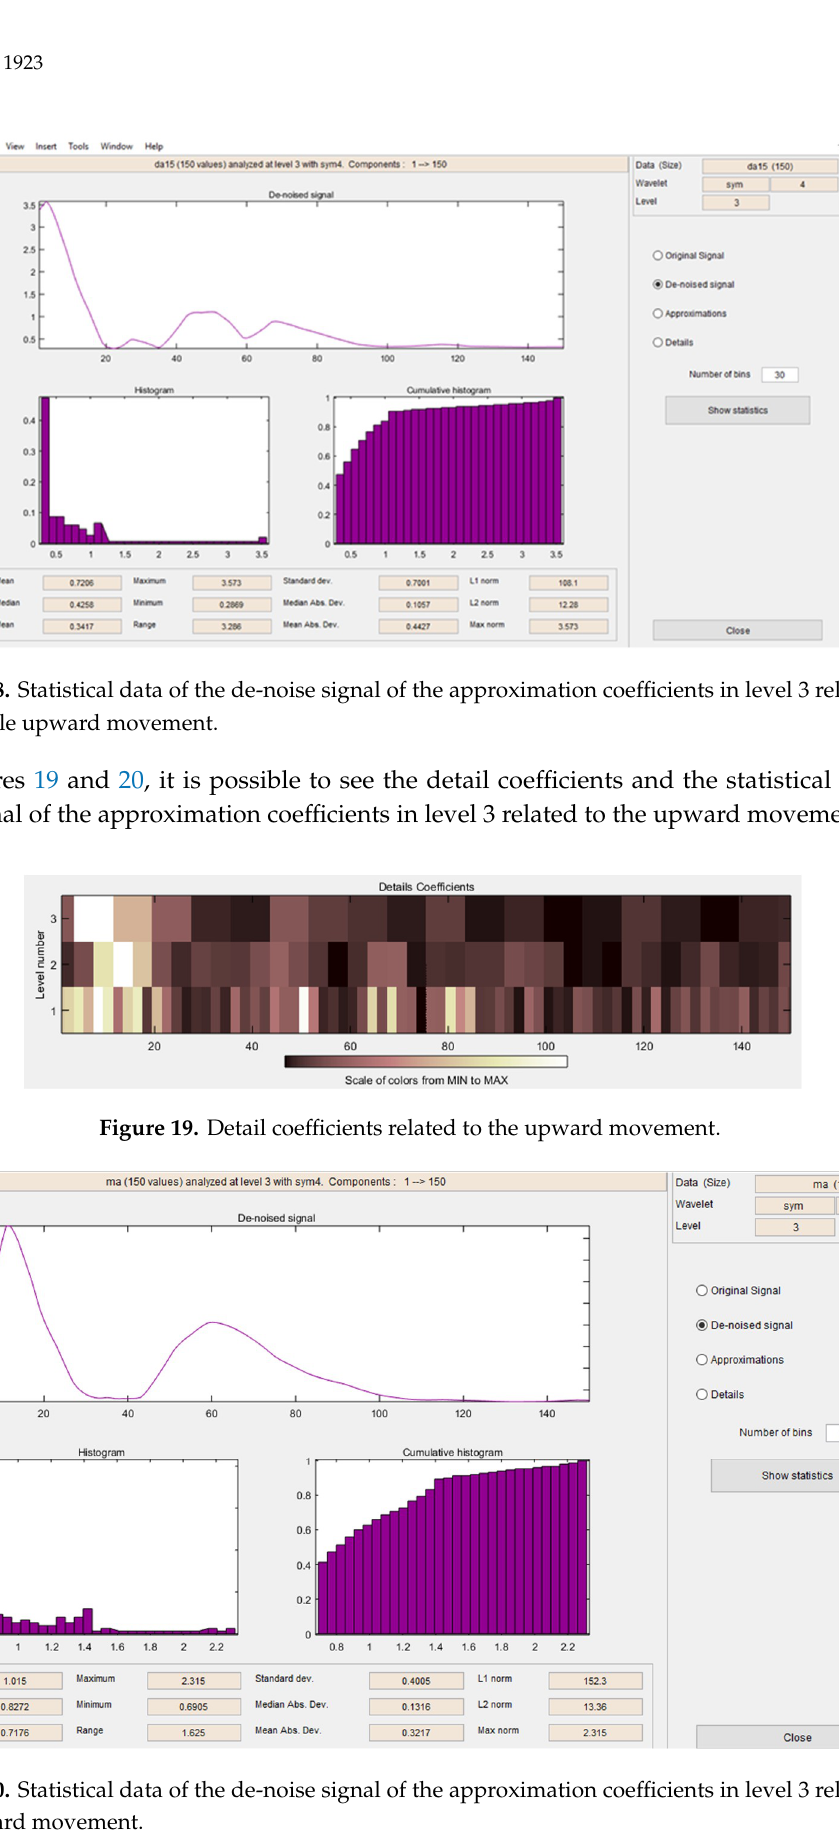
Figure 21. Detail coefficients related to the upward-downward movement. Figure 22. Statistical data of the de-noise signal of the approximation coefficients in level 3 related to the upward-downward movement. With the obtained coefficients values, it is possible to see that there is a general behavior related to each arm movement, indeed some coefficients were proved in a raw form, to generate control words, however, we have used such coefficients as input data in a classification tool, a neural network.